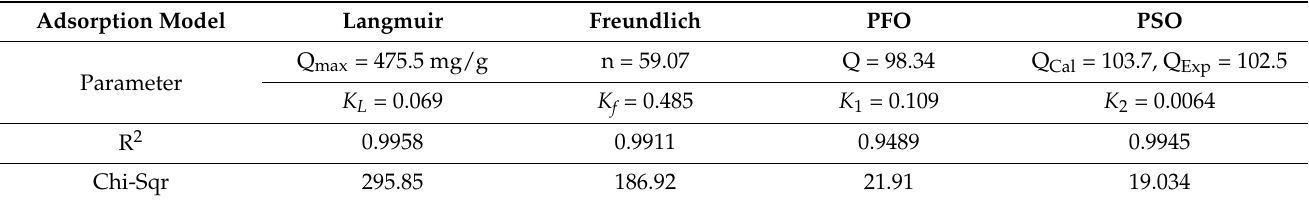
Figure 8. Cd (II) adsorption fitted with nonlinear Langmuir ( a ) and Freundlich model ( b ). Table 1. Cd ions equilibrium adsorption and kinetics models parameters computed.